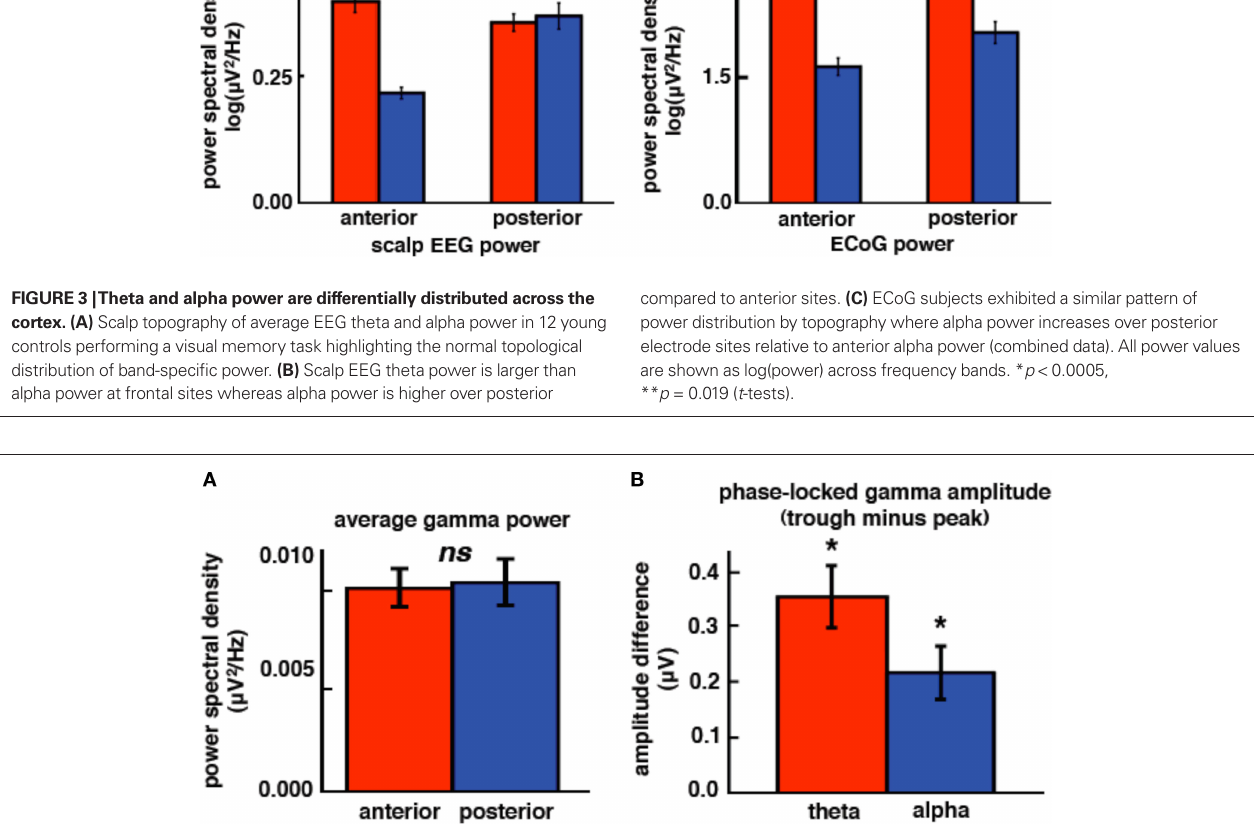
Figure 4 | High gamma is modulated by low-frequency phase but not topography. (A) High gamma power is equal across anterior and posterior ECoG electrode sites. (B) High gamma amplitude is a function of theta and alpha phase such that high gamma amplitude is greater at the troughs of low frequencies compared to the peaks. * p < 0.0005 (paired-samples t -tests). ns , not significant. Error bars represent